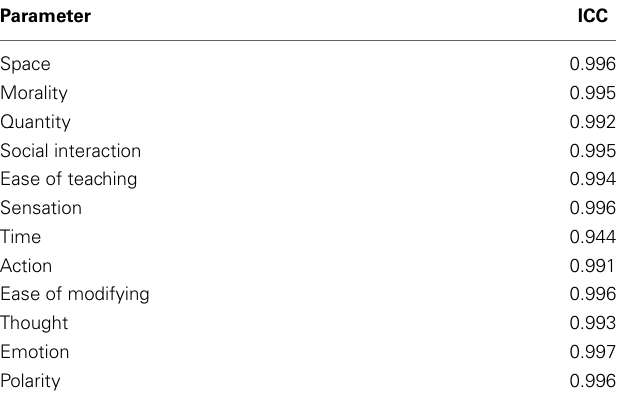
Table 2 | Inter-rater reliability.